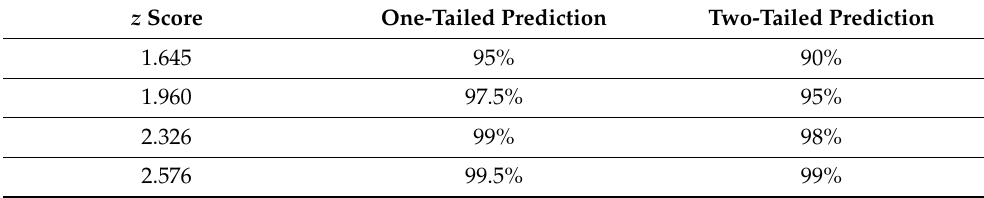
Table 9. Confidence levels corresponding to z scores for one- and two-tailed predictions [62]. z Score One-Tailed